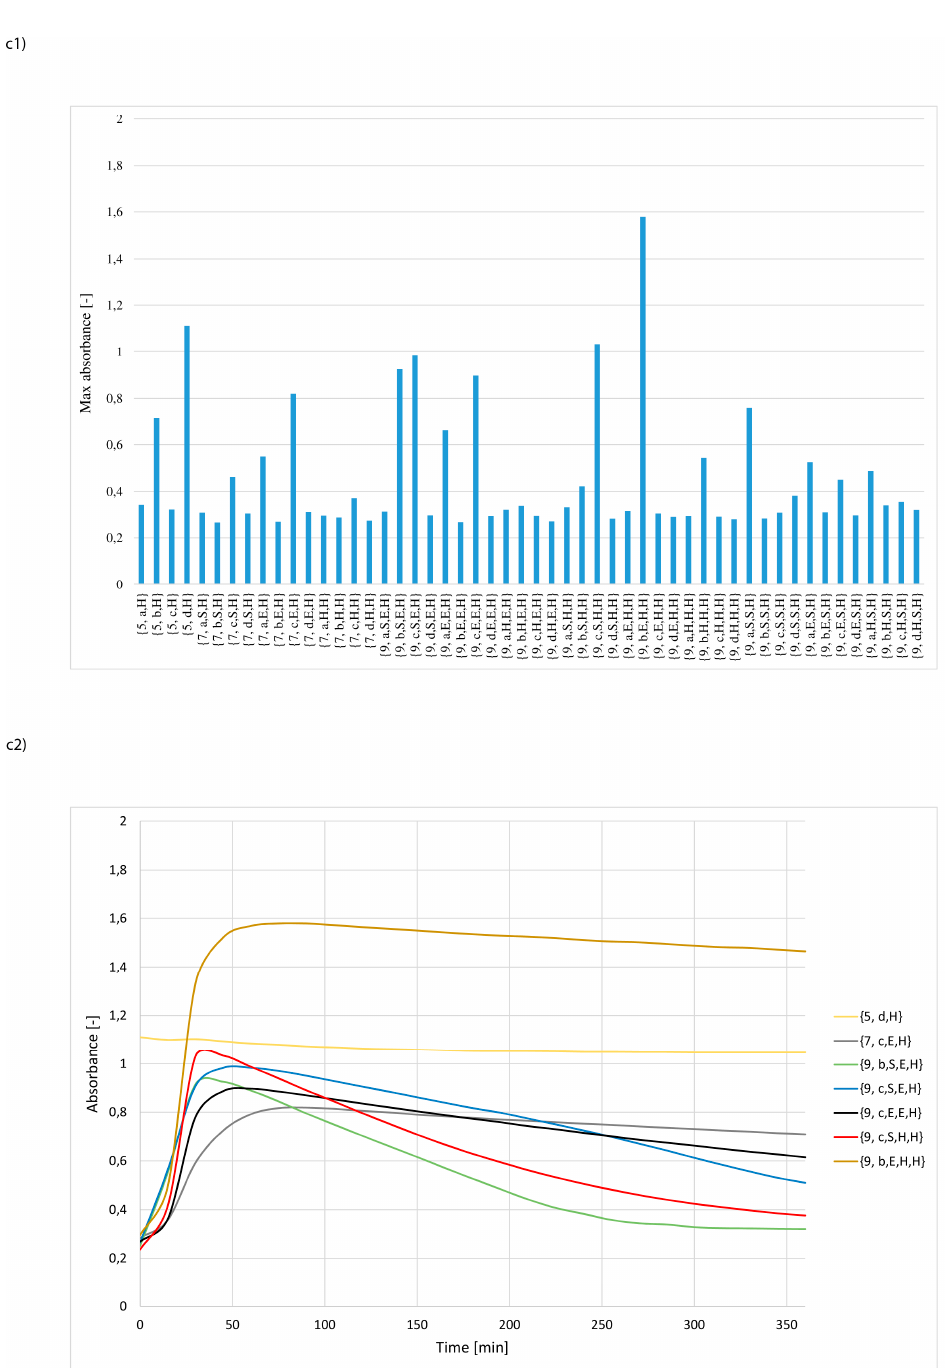
Figure 6. Selection of the most active synzymes (maximum absorbance assay) (upper panel 1) and measurement of Z-Leu-NA hydrolysis in a solution at pH = 8.5 using the selected the most active synzymes (lower panel 2) with Cu 2+ ions docked in the catalytic pocket: ( a ) sub-library of synzymes with serine reside at C-terminal positions, ( b ) sub-library of synzymes with glutamic acid reside at C-terminal positions, ( c ) sub-library of synzymes with histidine reside at C-terminal positions. The influence of the Zn 2+ ion on the rate of hydrolysis was also studied. The method used to prepare 156 strips saturated in 0.5 M ZnCl 2 solution and monitoring the hydrolysis progress was identical to that described previously for copper ions. The results are collected in Figure 8a–c and Figure